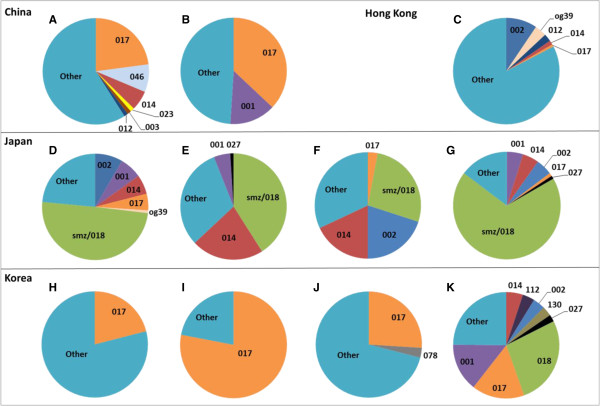
Ribotype distributions for studies in China (A,B), Hong Kong (C), Japan (D-G) and Korea (H-K). A: n = 75 isolates collected in 2008; 33 ribotypes identified [37]. B: n = 110, December 2008-May 2009; 16 ribotypes [39]. C: n = 345, 2009; 106 ribotypes [40]. D: n = 87, March 1996-November 1999; 12 ribotypes [8]. E: n = 148, November 1999-October 2004; 26 ribotypes [16]. F: n = 71, April 2005-March 2008; 20 ribotypes [14]. G: n = 87, 2003–2007; 18 ribotypes [17]. H: n = 187, 1980–2006; 39 ribotypes [27]. I: n = 105, 1995–2008; 11 ribotypes [32]. J: n = 337 toxigenic isolates, 2006–2008; 50 ribotypes [31]. K: n = 194, 2009–2010; 54 ribotypes [19].